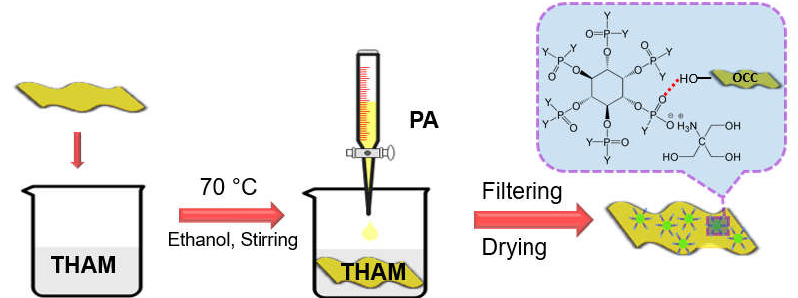
Figure 1. Scheme diagram of OCC modification with PA-THAM.